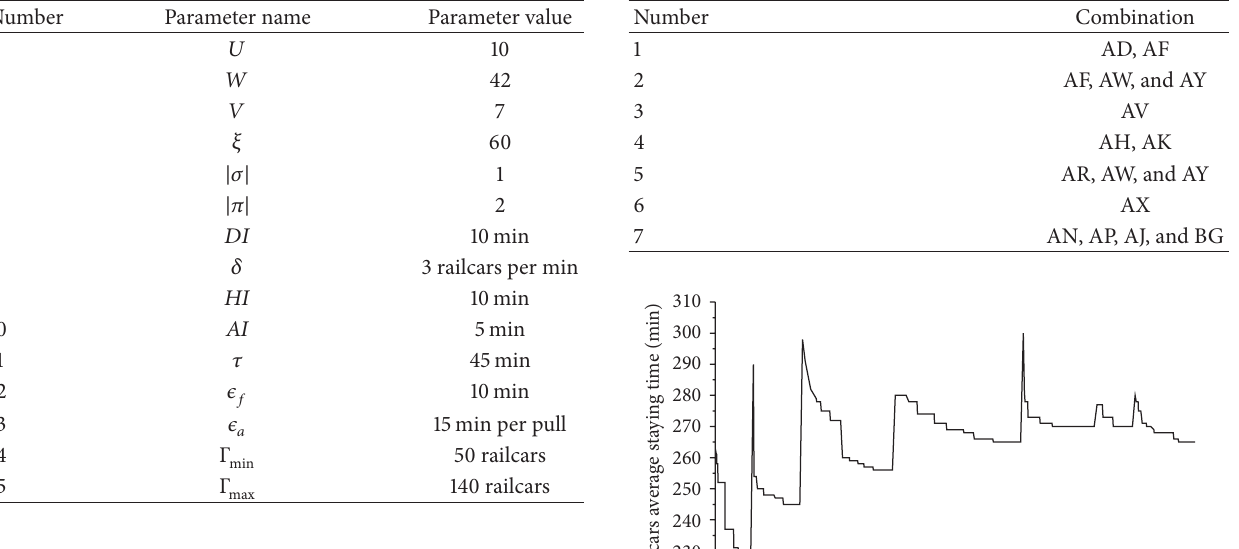
Table 2: Some parameters’ values of marshalling station. Table 3: Directions combination for assembling outbound train.